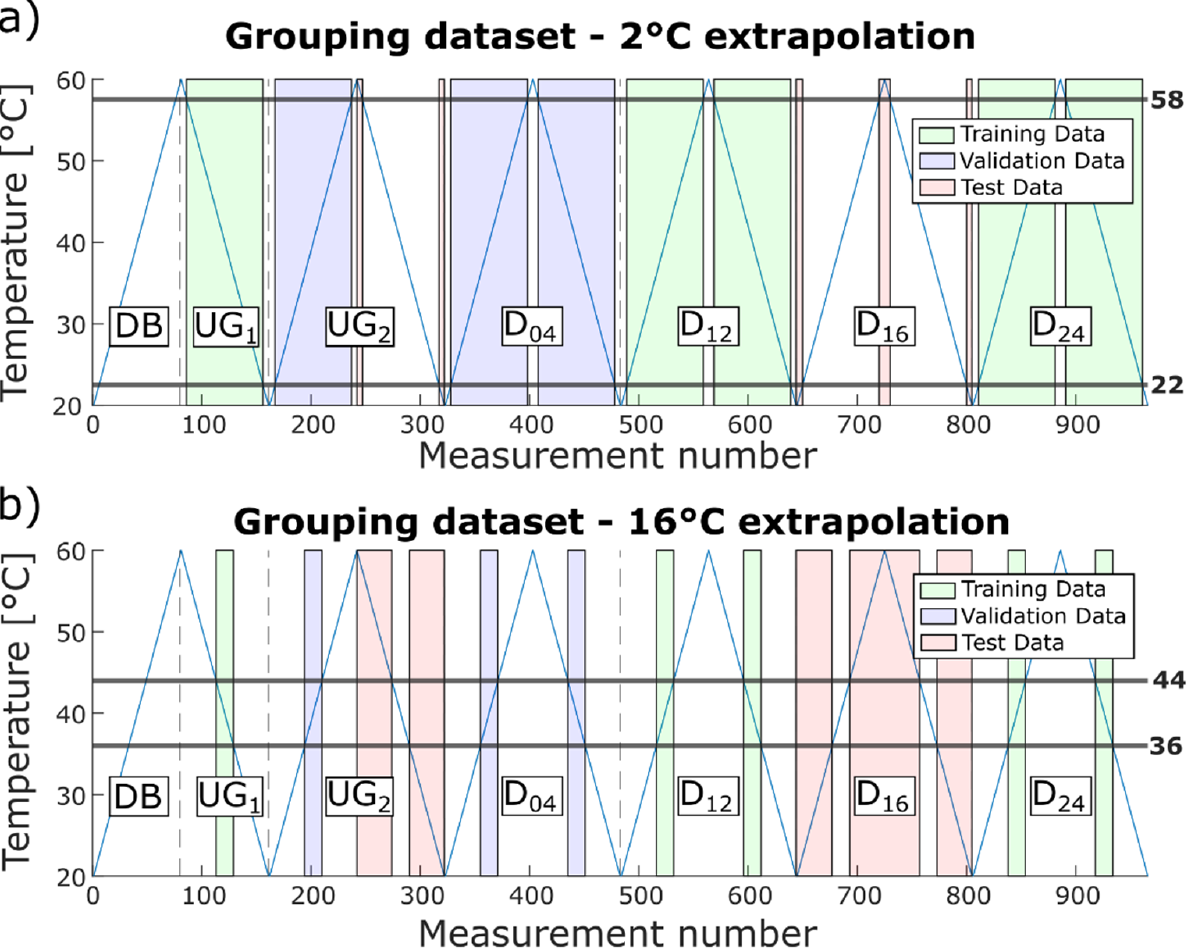
Figure 8. Grouping of the data into training, validation, and test data for ( a ) 2 °C and ( b ) 16 °C Figure 8. Groupingofthedataintotraining, validation, andtestdatafor( a )2 ◦ Cand( b )16 ◦ extrapolation.